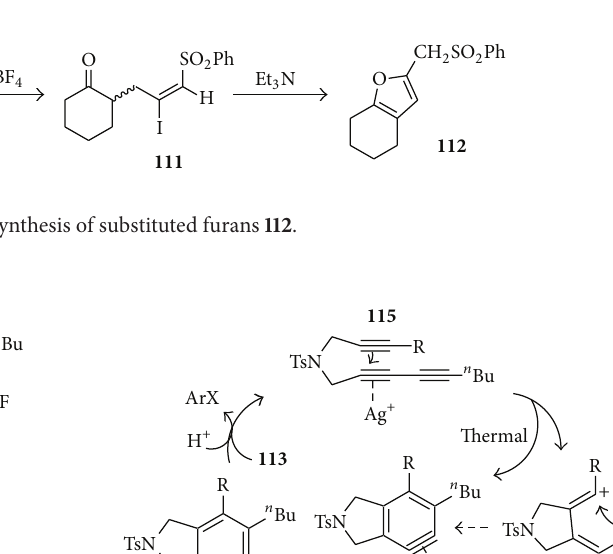
Scheme 23: Proposed reaction mechanism to afford the 2,3-dihydrofuran.